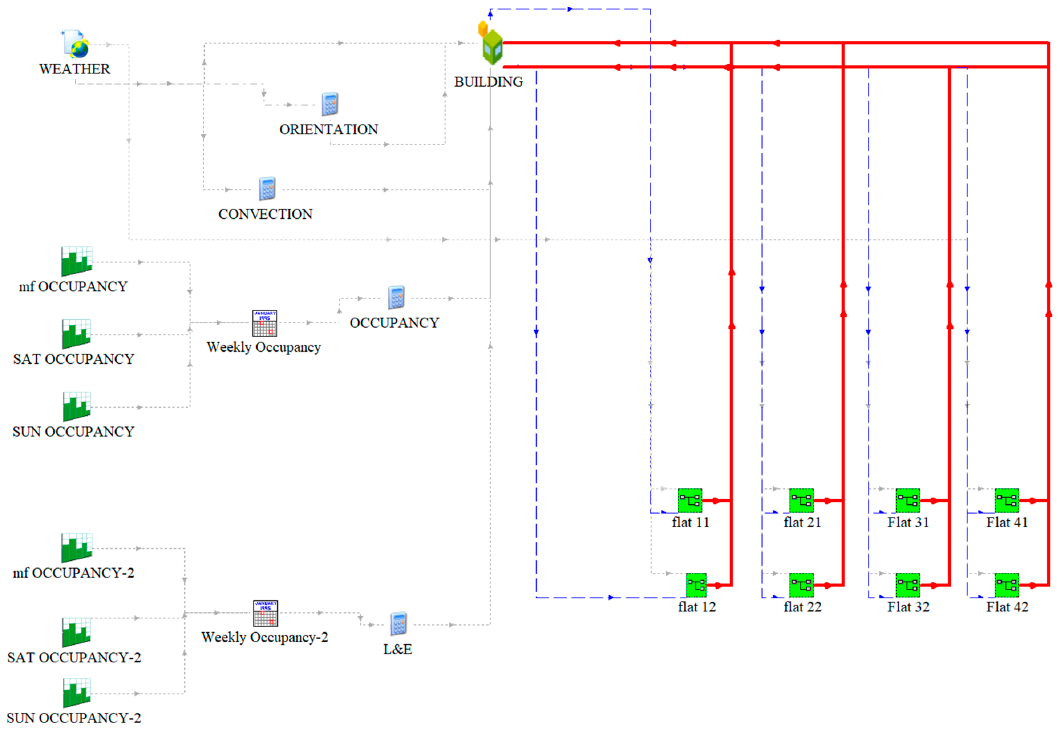
Figure 4. TRNSYS Simulation Model. Blue lines show cold streams, red shows hot streams and grey shows auxiliary streams (occupancy schedules, control signals etc.).